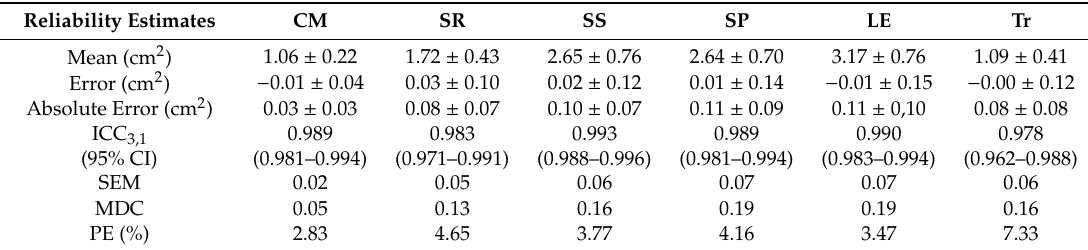
Table 2. Intra-examiner reliability of panoramic ultrasound imaging.